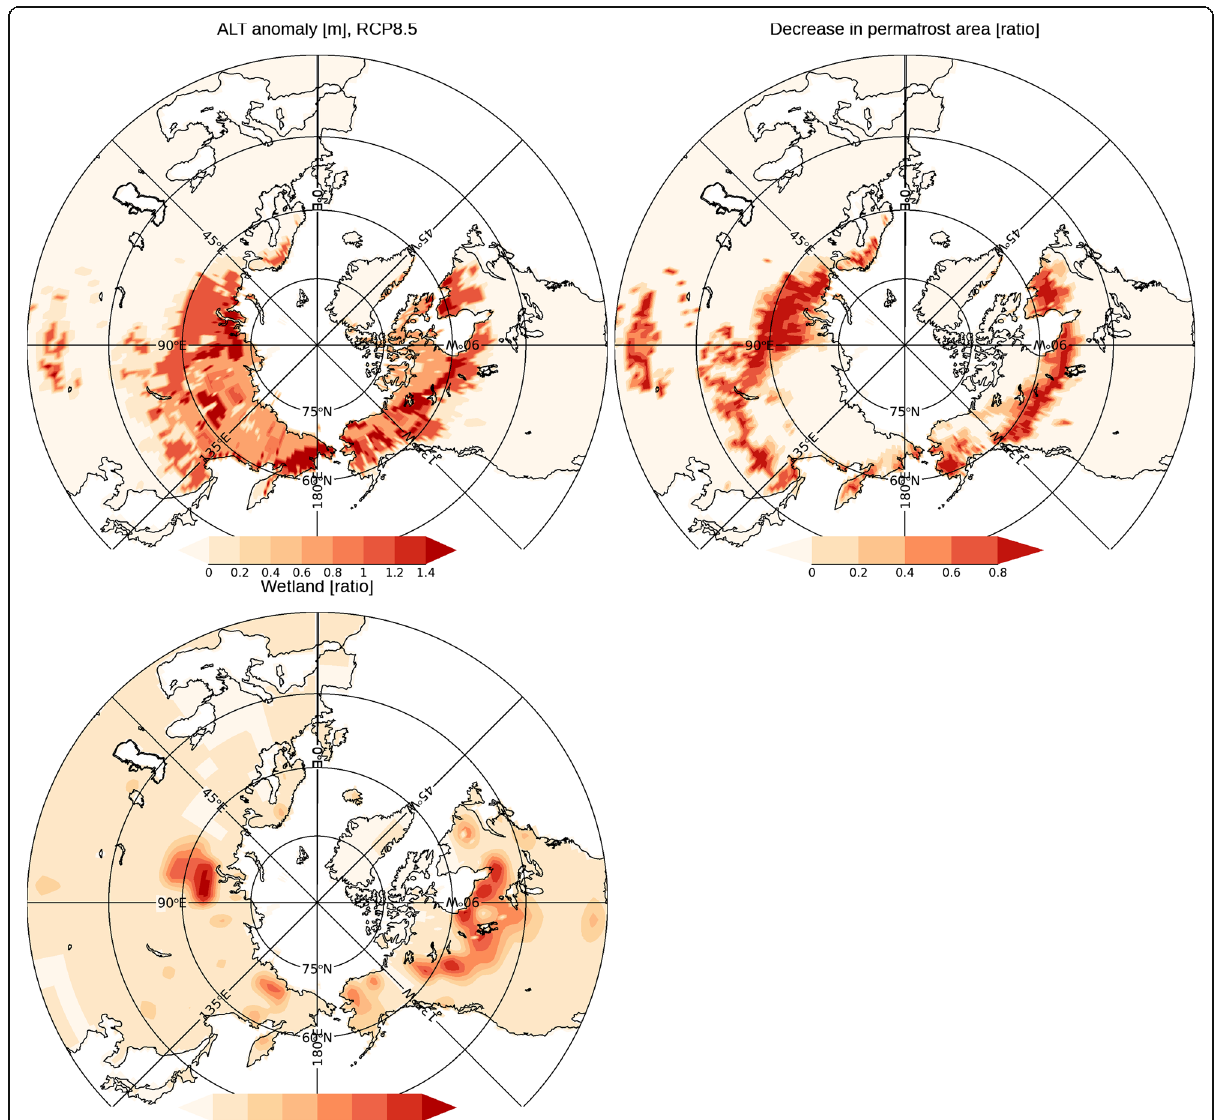
Fig. 6 Total change in active layer thickness [m] (top left), decrease in the permafrost area (top right), the wetland fraction (bottom) at the end of the twenty-first century in the RCP8.5 scenario. The average of all ensemble members is